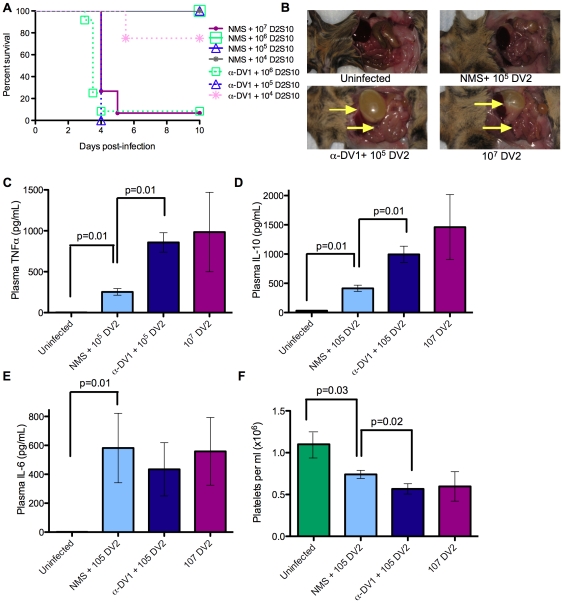
Lethal enhancement of dengue disease by anti-DV sera.
A. Mice were administered 100 µl naïve mouse serum (NMS) or anti-DV1 serum (α-DV1), challenged iv with the indicated dose of DV2 strain D2S10 24 hours later, and monitored for survival. Kaplan-Meier survival curves are shown; see Table S1 for p-values. The numbers of mice per group are as follows: NMS +107 D2S10, 15; NMS +106 D2S10, 8; NMS +105 D2S10, 11; NMS +104 D2S10, 4; α98J +106 D2S10, 12; α98J +105 D2S10, 4; α98J +104 D2S10, 4. B–F. Disease parameters were compared in mice receiving no virus, 107 pfu DV2, or 105 pfu DV2 after transfer of naïve or anti-DV1 serum. B. Vascular leak-associated fluid accumulation in visceral organs at day 3.5 post-infection. C–E. Serum levels of TNF-α (C), IL-10 (D), and IL-6 (E) in infected mice at day 3.5 post-infection were measured by ELISA (eBioscience). F. Platelet counts in mice at day 3.5 post-infection were determined using a hemocytometer. In (C–F), n = 4 in all groups except the uninfected group in panel F, where n = 12. Error bars represent standard deviations, and two-sided Wilcoxon rank sum tests were used to determine statistical significance.